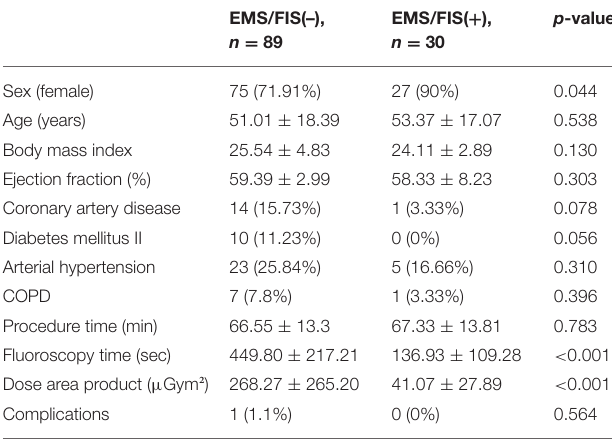
groups showed no significant differences concerning age (51.01 ±